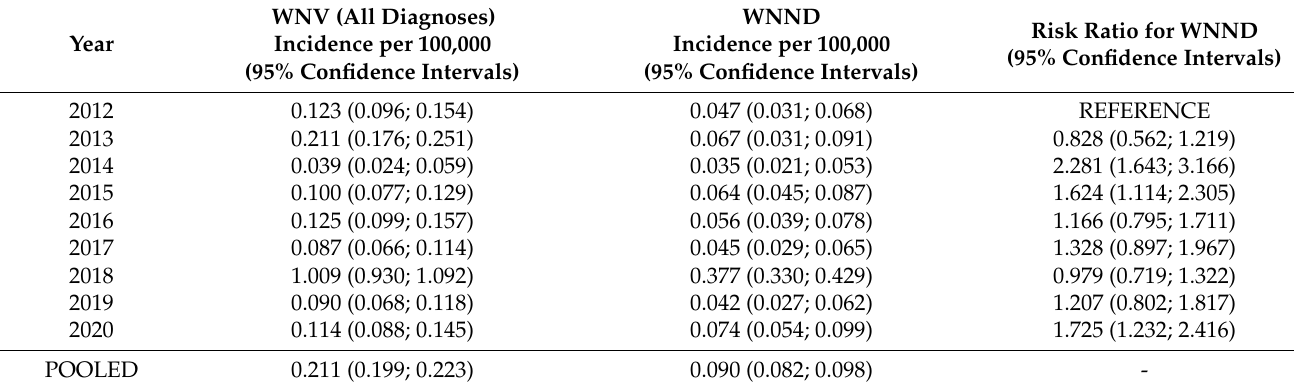
Table 2. Incidence of West Nile virus infections (WNV) in Italy (2012–2020), with the correspondent estimates for the subgroup of West Nile neuro-invasive disease (WNND). Crude incidence data were estimated assuming the total Italian population as the reference. Risk ratio and respective 95% confidence intervals were calculated assuming 2012 as the reference